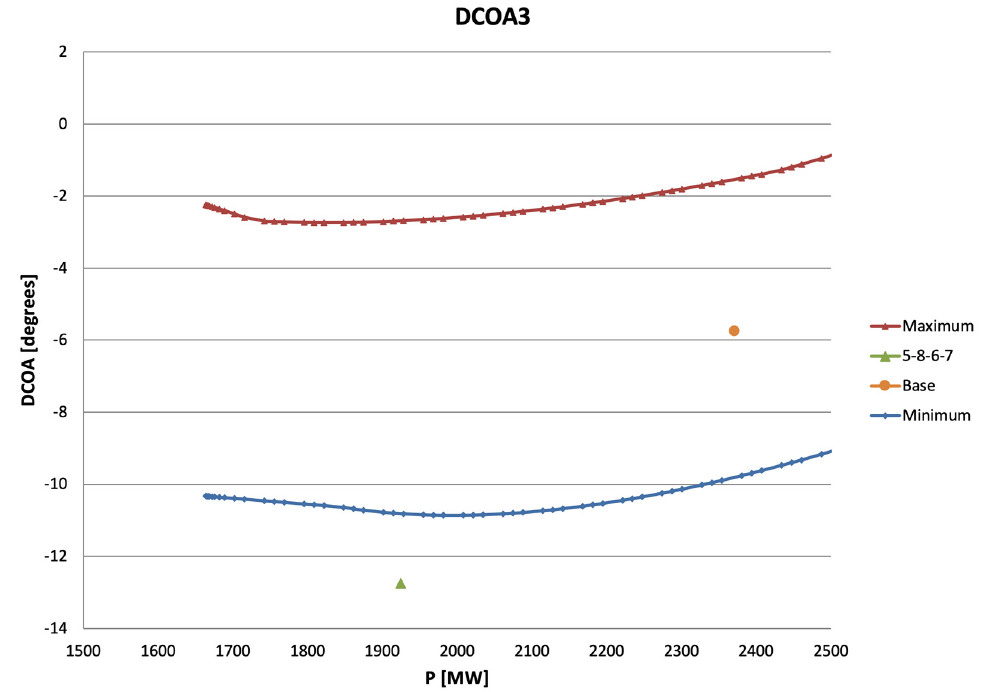
Figure 17. Angular thresholds characterization for contingencies N-1 in operational area 3 (outages of lines 5–8 and 6–7).